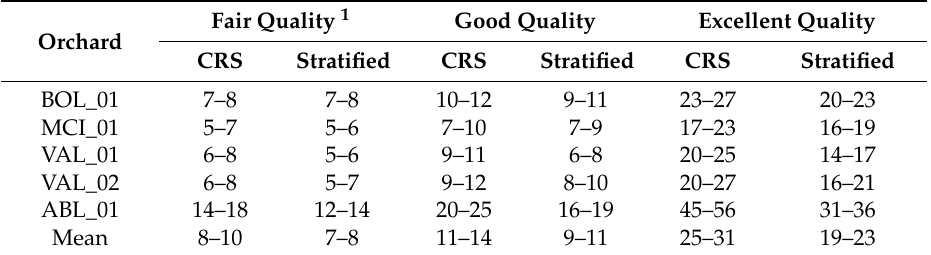
Table 4. Minimum sample sizes (MSS) required to estimate fruit count in the orchards using completely randomized (CRS) or stratified samplings (Stratified). Values correspond to the 95% confidence intervals in 10 4 replicated samplings.